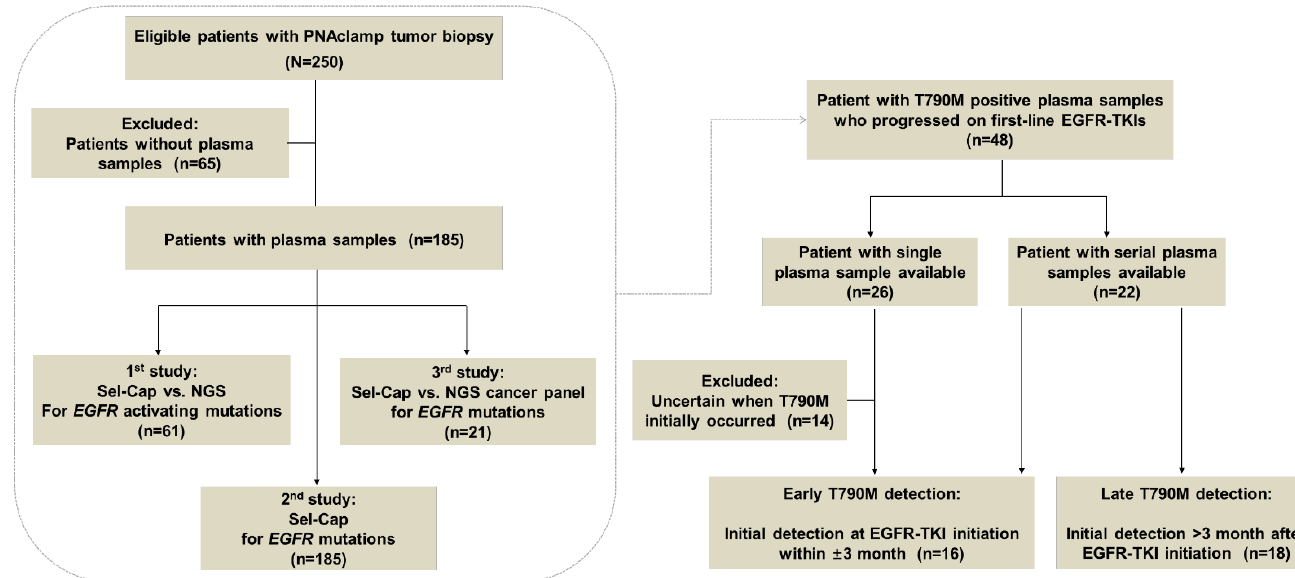
Figure 1. CONSORT flow diagram for the present study. NGS, next-generation sequencing; EGFR-TKI, epidermal growth factor receptor-tyrosine kinase inhibitor.